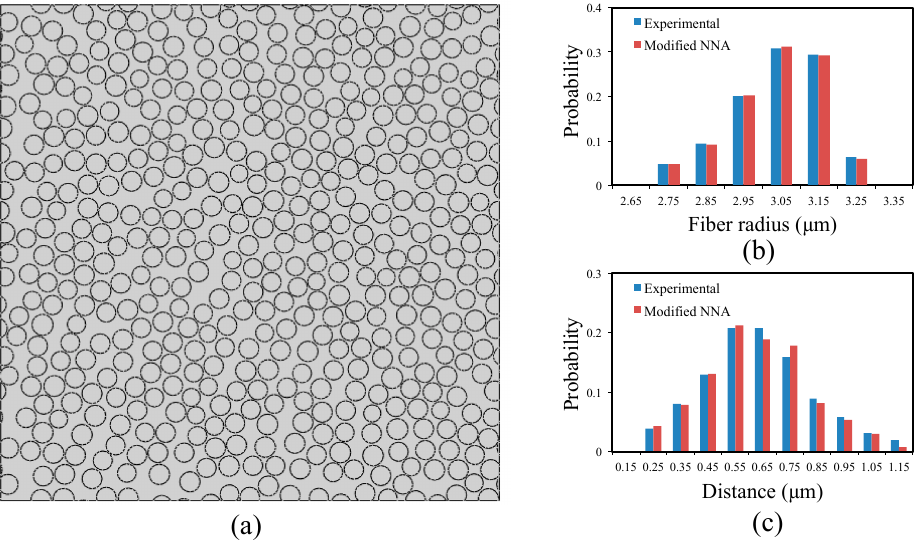
Figure 3. ( a ) Example of generated representative volume element (RVE) of fiber volume ration 57%; ( b ) distribution of fiber radius; and ( c ) distribution of nearest neighbor distances.